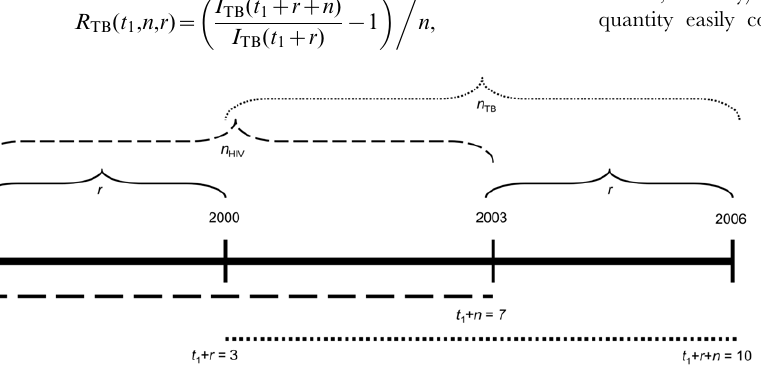
Figure 1. Timeline used to generate R TB = HIV ( t 1 , n , r ) values depicted in Figure 2. The HIV time frame starts at t 1 =0, corresponding to 1997. In order to track the impact of HIV on TB, we delay the TB time frame by r =3 years. Accordingly, we analyze TB data starting at t 1 + r =3 years, i.e. 3 years after 1997, which corresponds to the year 2000. We have TB data until the year 2006, such that the length of our TB time frame spans 2000–2006, for a total of n =7 years of TB data. Under our formulation this corresponds to t 1 + r + n =10. Because optimally we compare trends for the same number of years for the two diseases, we also use 7 years of HIV data, t 1 + n =7 years, i.e. from 1997–2003. Dashed lines indicate HIV, dotted lines indicate TB.